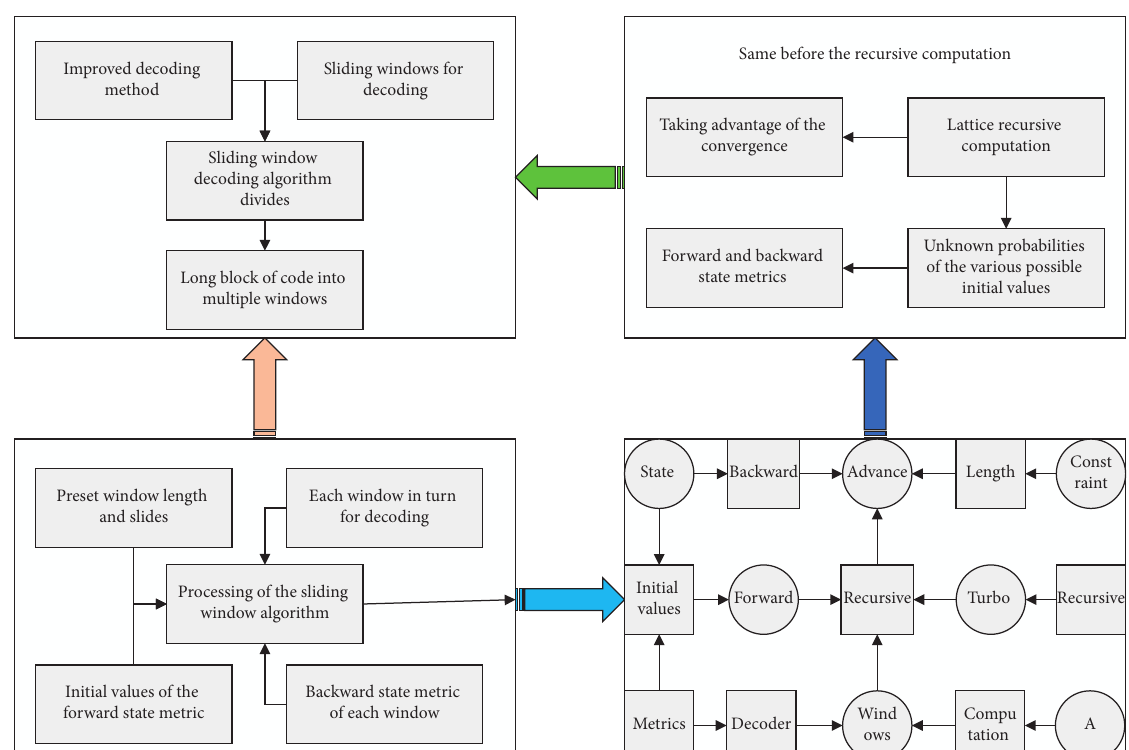
Figure 7: Block diagram of Turbo code iterative decoding